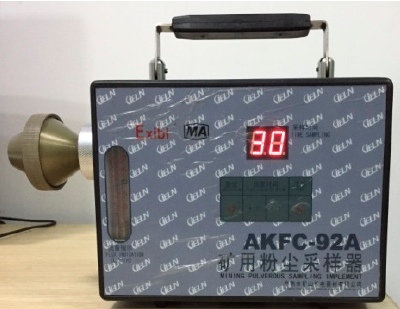
Figure 7. Coal mine dust sampler.